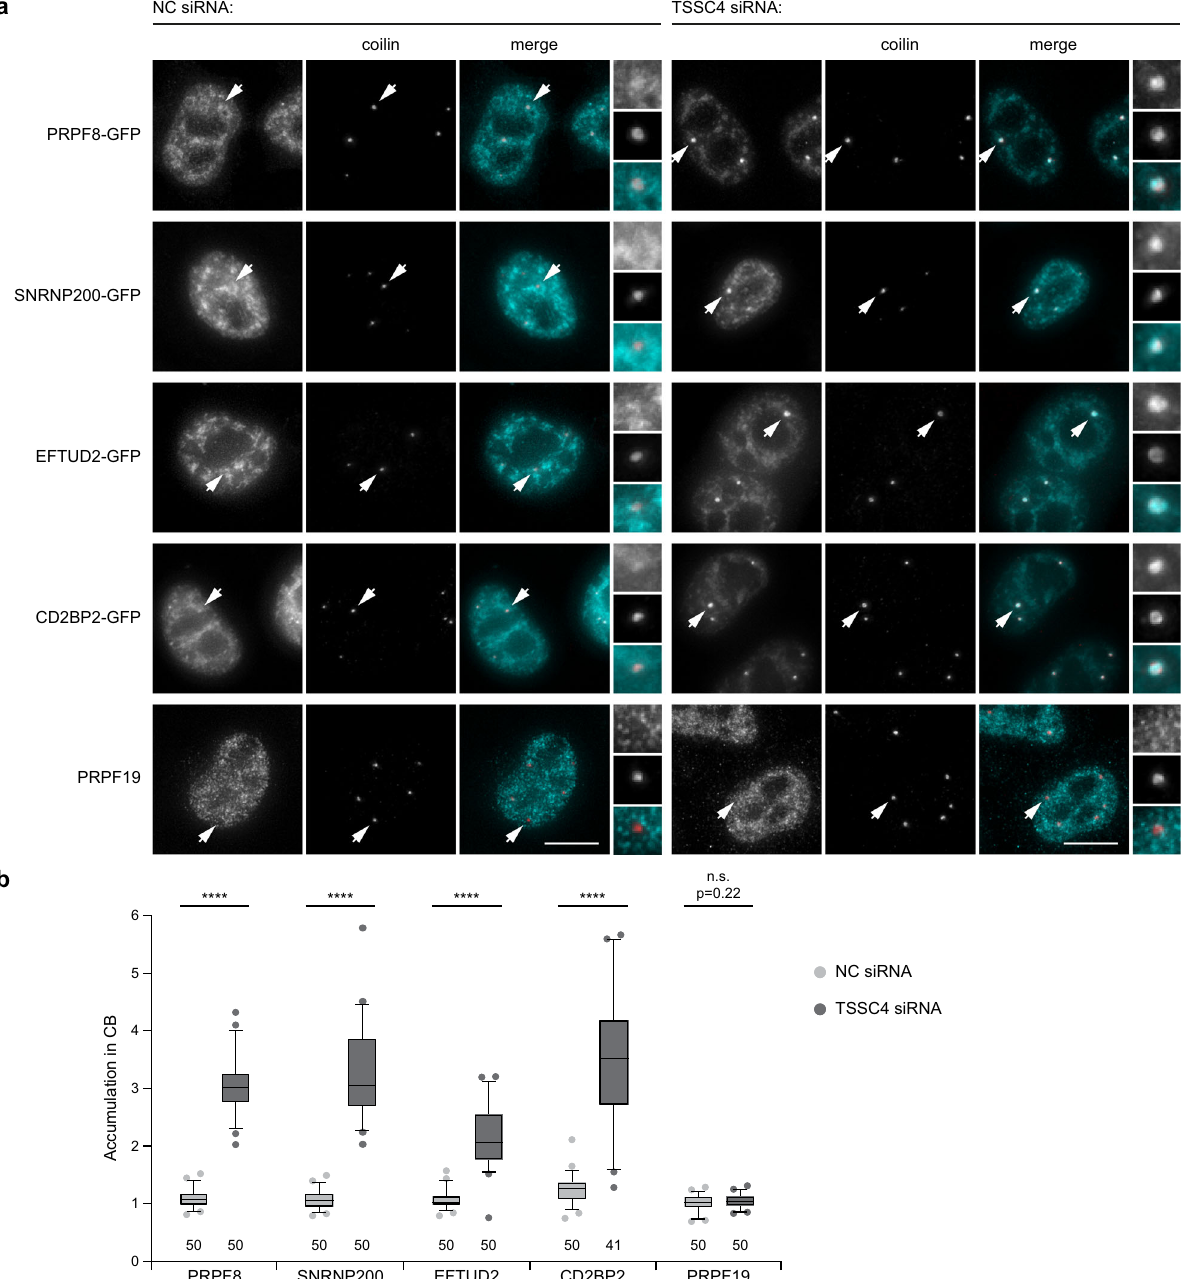
Fig. 6 TSSC4 downregulation increases the accumulation of U5-speci fi c proteins in Cajal bodies. a Knockdown of TSSC4 by RNAi increased the accumulation of U5-speci fi c proteins in Cajal bodies. PRPF19 was visualized by indirect immuno fl uorescence, the other proteins were tagged with GFP and stably (PRPF8-GFP and SNRNP200-GFP) or transiently (CD2BP2-GFP and EFTUD2-GFP) expressed in HeLa cells (turquoise). Cajal bodies were visualized by immunodetection of coilin (red). Cajal bodies marked by arrows are enlarged three times in insets. Scale bars represent 10 μ m. b Quanti fi cation of Cajal body accumulation. Fluorescence signal in Cajal bodies was normalized to signal in the nucleoplasm and shown in a box plot (center line — median; box limits — 1st and 3rd quartiles; whiskers — 5th and 95th percentile). Two lowest and two highest values are depicted as separate dots in each box plot. The number of analyzed cells is shown at the bottom of the diagram. Statistical signi fi cance was determined by the two-tailed T test, and all P values lower than 0.0001 are indicated by ****. Original values for box plots are provided in the Source Data fi le. a , b Two biologically independent experiments were performed for each condition and